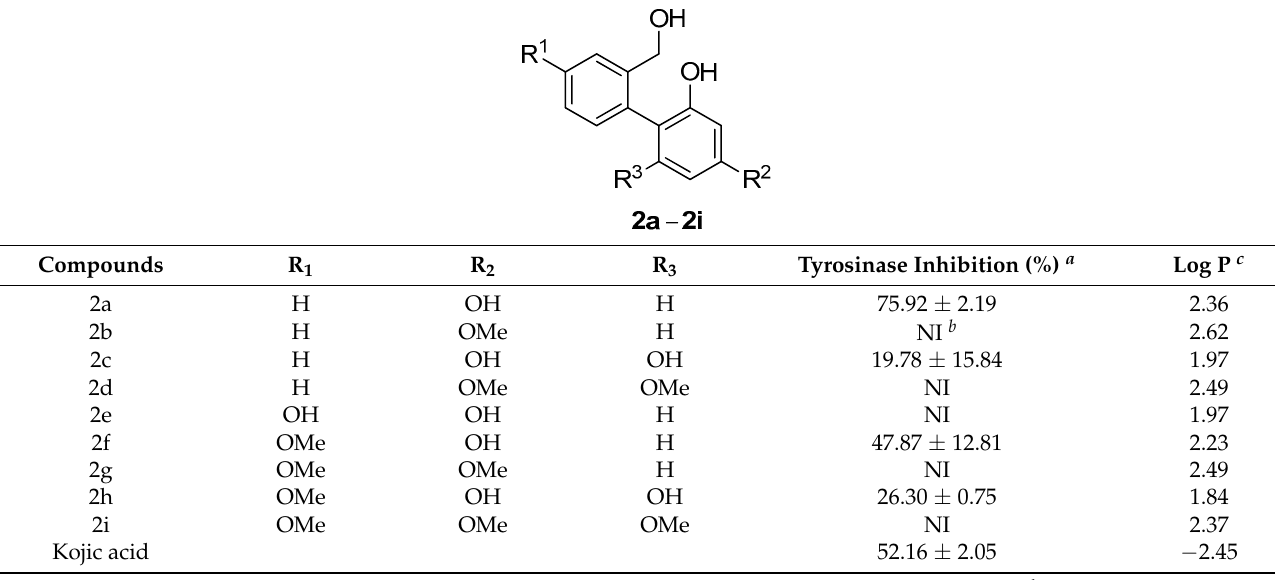
a Tyrosinase inhibition was assessed for all compounds at a concentration of 50 µ M using L-tyrosine as substrate. b NI means no inhibition. Results are presented as mean ± SEMs. c Log P values were obtained by ChemDraw Ultra 12.0.